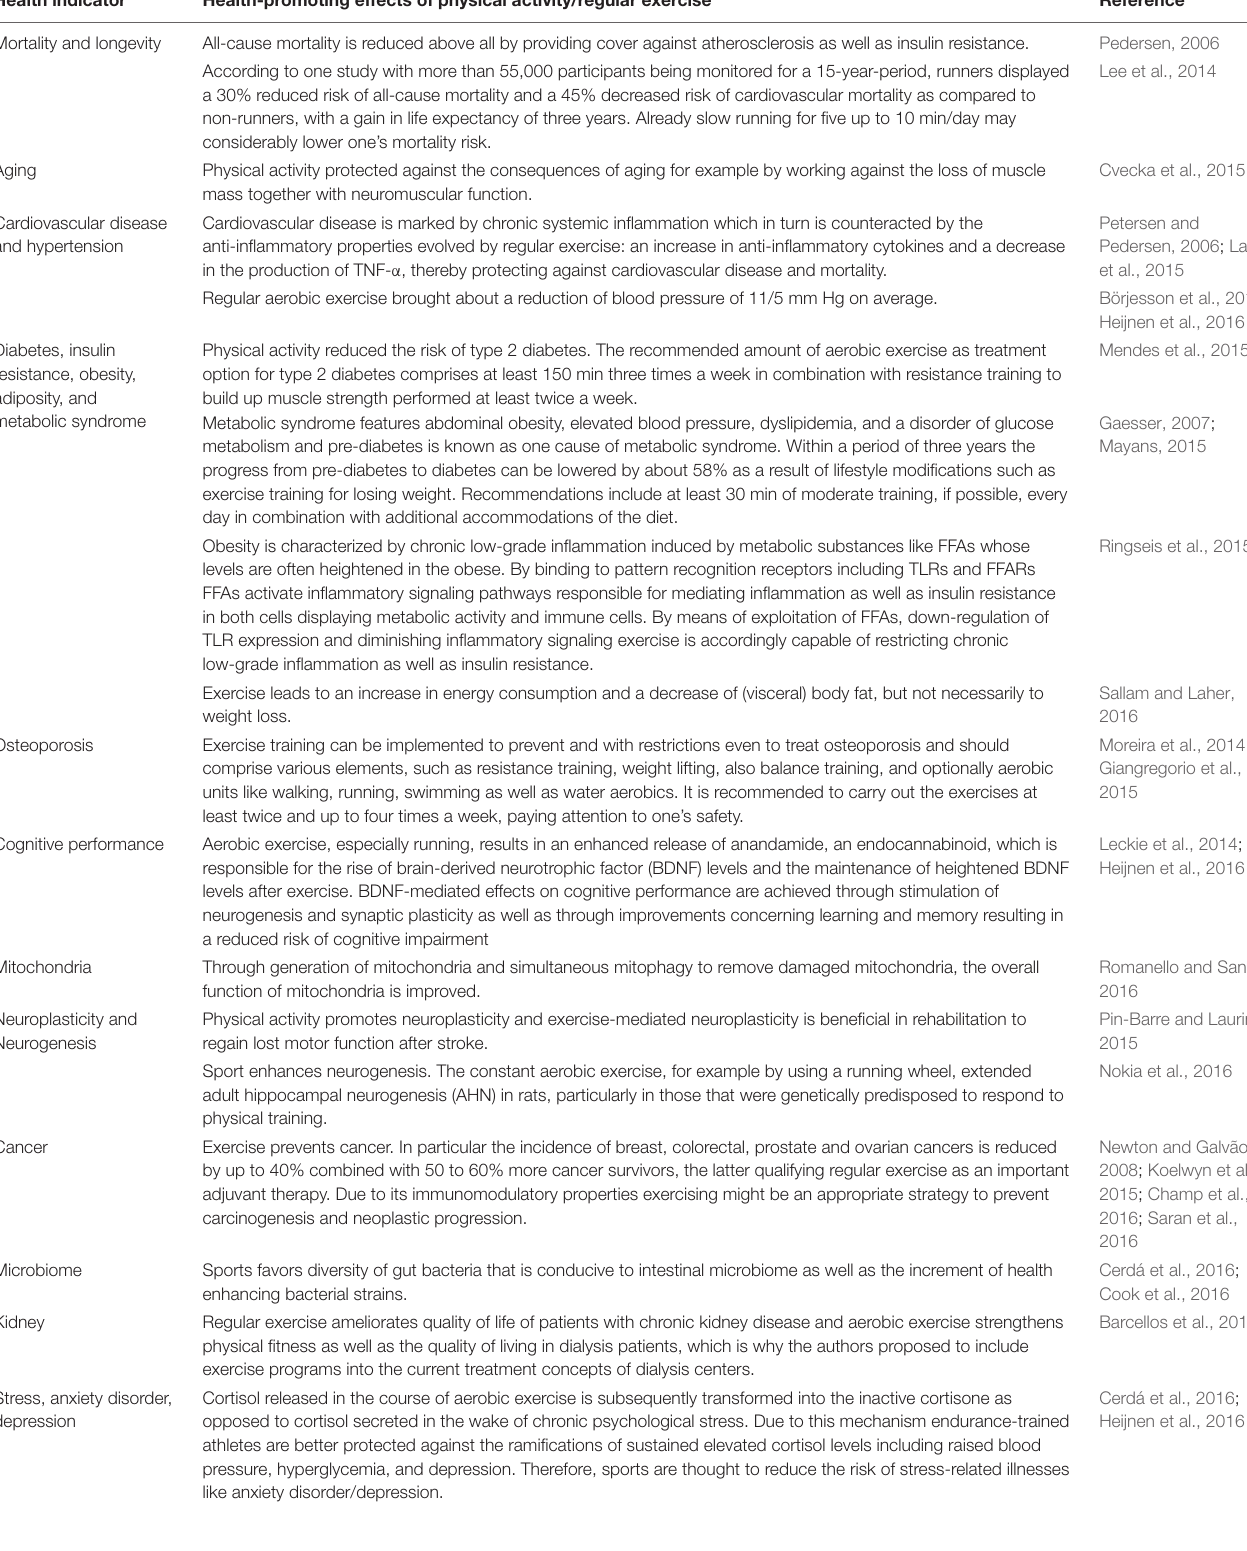
TABLE 1 | Health-promoting effects of physical activity/regular